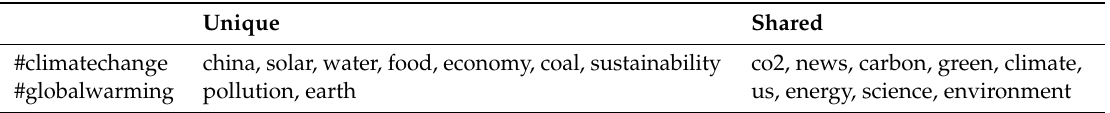
Table 2. Hashtags that remained on the top 50 list for the climate change or the global warming discourse from 2009 to